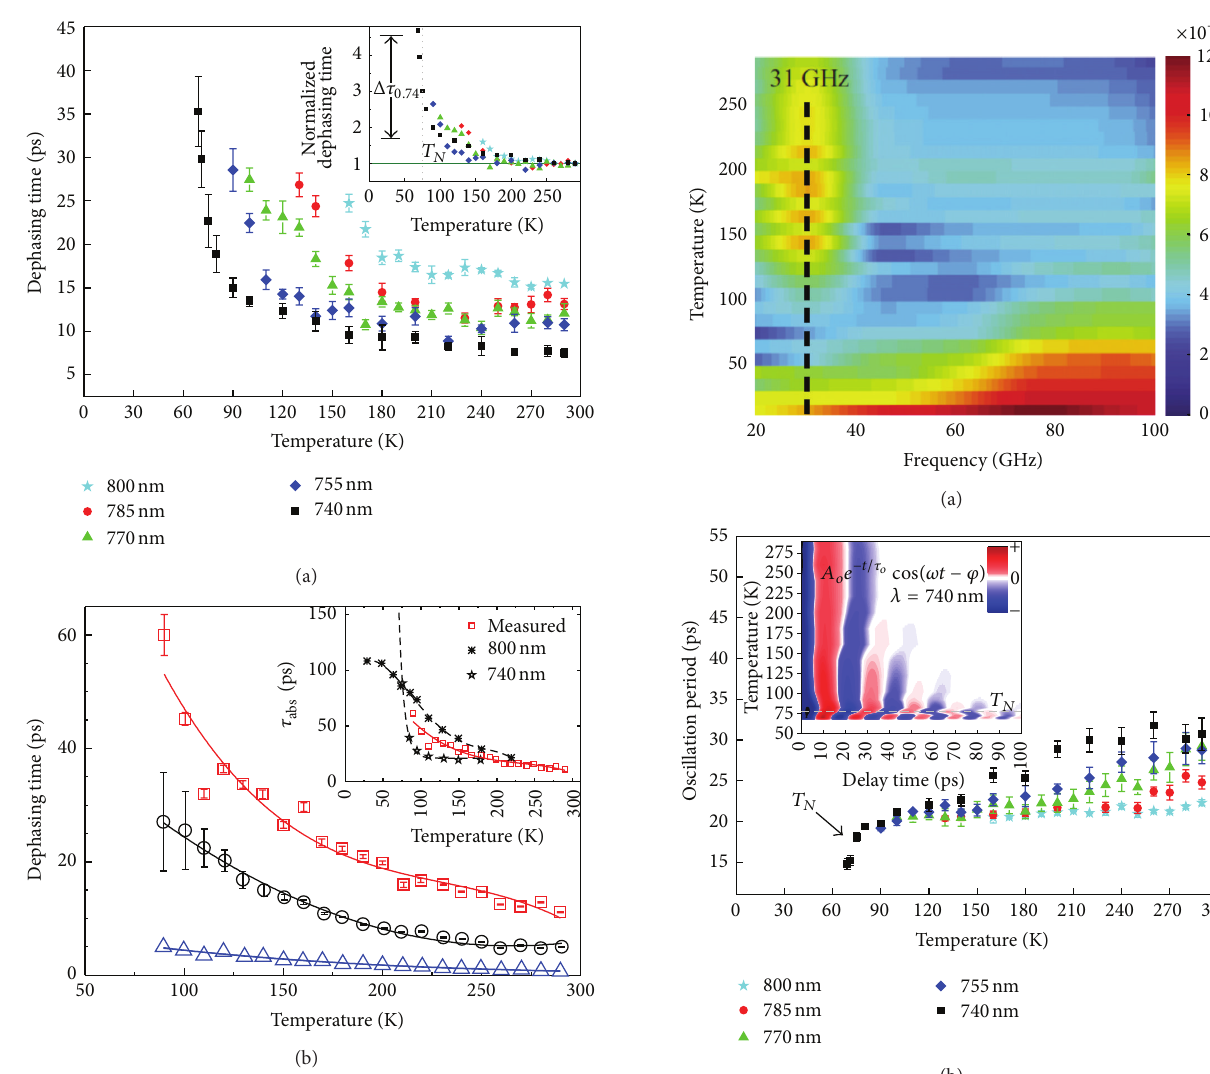
Figure 11: (a) Fourier transform amplitudes for coherent oscillation of YMnO 3 [39]. Reprinted with permission from Jang et al. [39]. Copyright 2010, American Institute of Physics. (b) Temperature dependence oscillation period in Δ𝑅/𝑅 at various wavelengths of HoMnO 3 . Inset: the evolution of the oscillation component in Δ𝑅/𝑅 at various temperatures [38]. Figures were reproduced with permission from Shih et al.